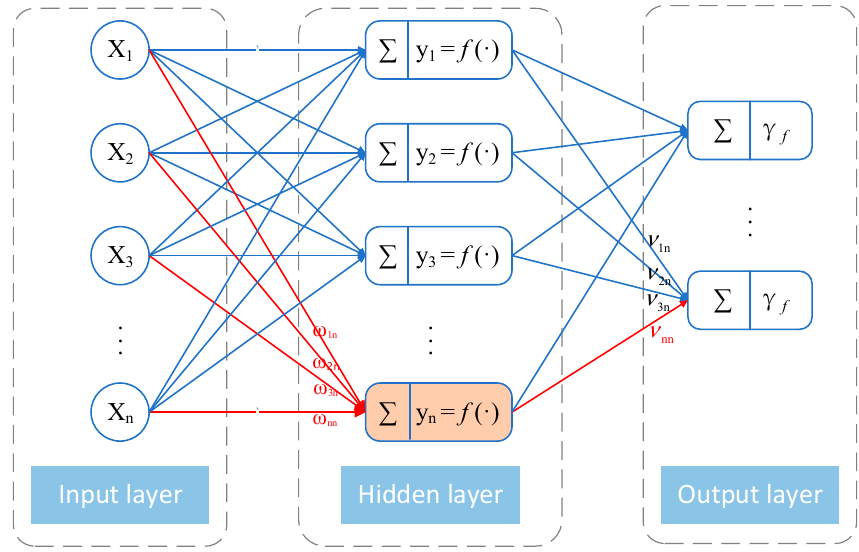
Figure 7. Topological structure of BP neural network model.